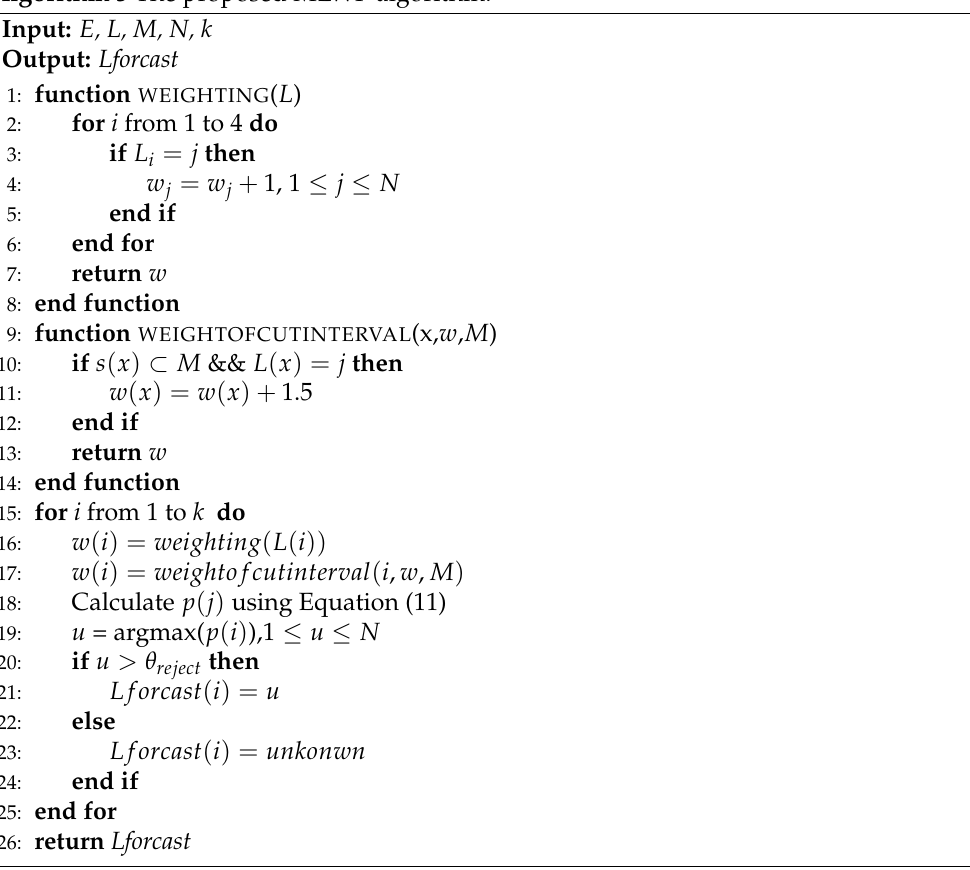
Algorithm 3 The proposed MLWP